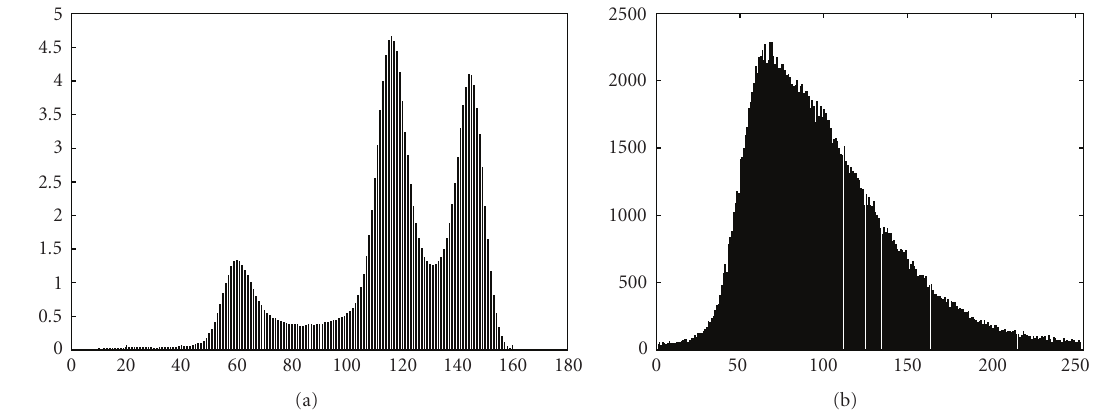
Figure 8: Histogram of a (a) T 1 -weighted image and a (b) T 1